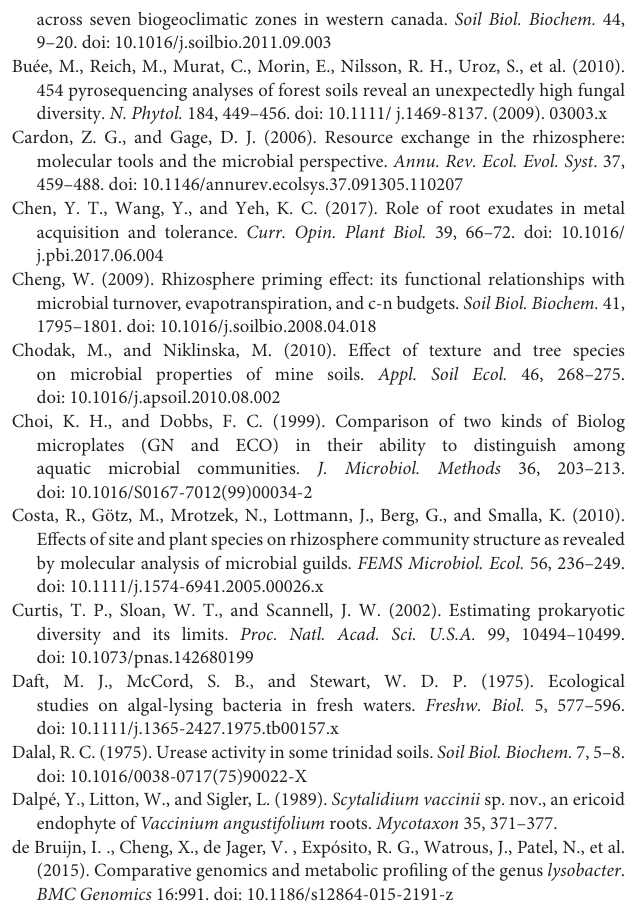
genus), showing differences among eight deciduous fruit